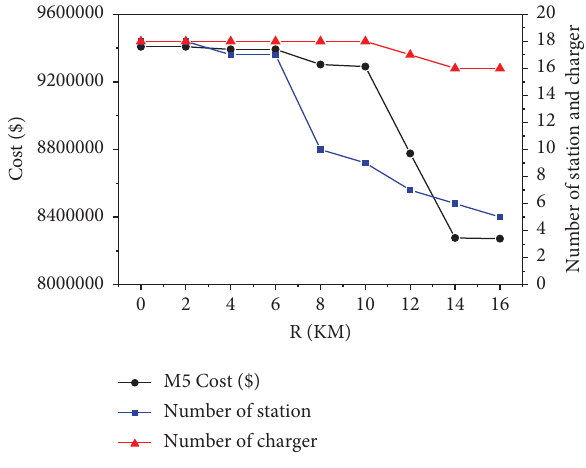
Figure 6: Model M 5 output variation. Table 5: Efect of the charging time on M 3 , M 4, and M 5 model outputs.